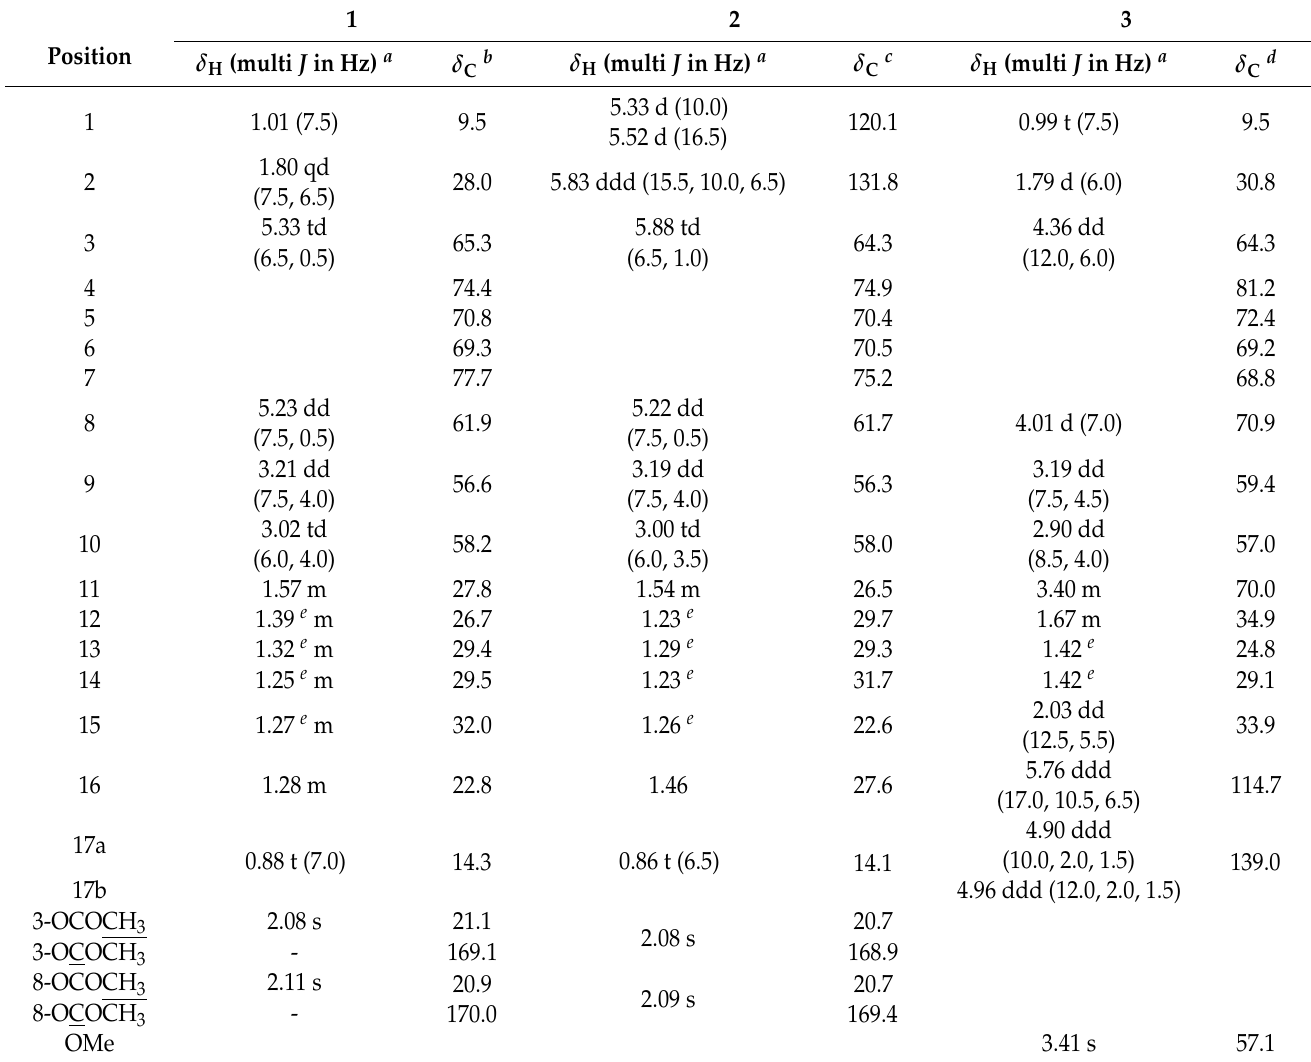
(Table 1; Figures S3 and S4). The COSY NMR spectrum revealed correlations between H-1 and H-2/H-3 and between H-8 and H-9/H-10, implying that the methyl, methylene, and oxygenated methine signals are connected (Figure 2 and Figure S5). The HMBC NMR spectrum displayed correlations between H-3 and 3-OCOCH 3 /3-OCOCH 3 and between H-8 and C-7/8-OCOCH 3 , suggesting that the two acetoxy groups are located at C-3 and C-8 (Figure 2 and Figure S6). Table 1. 1 H and 13 C NMR spectroscopic data of compounds 1 − 3 ( δ in ppm, chloroform- d